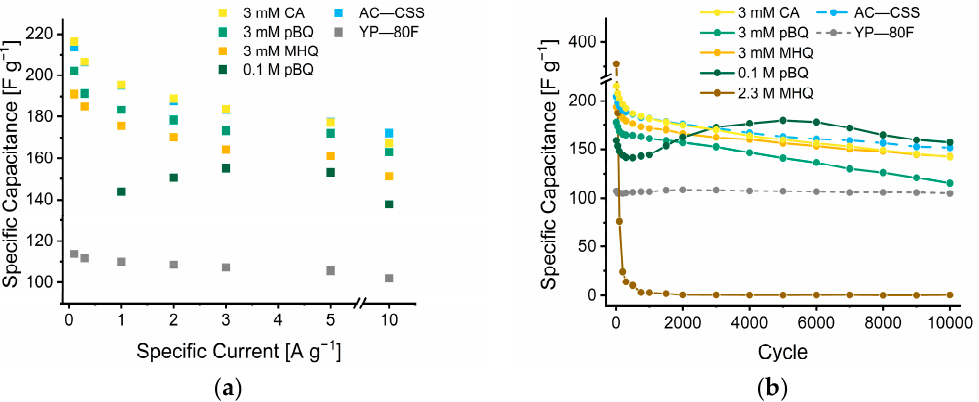
Figure 6. ( a ) Electrochemical characterization of AC—CSS with 1 M H 2 SO 4 as electrolyte, with optional addition of CA, pBQ, and MHQ at various scan rates. ( b ) Long term cycling of AC—CSS with optional addition of CA, pBQ, and MHQ at 2 A g − 1 .